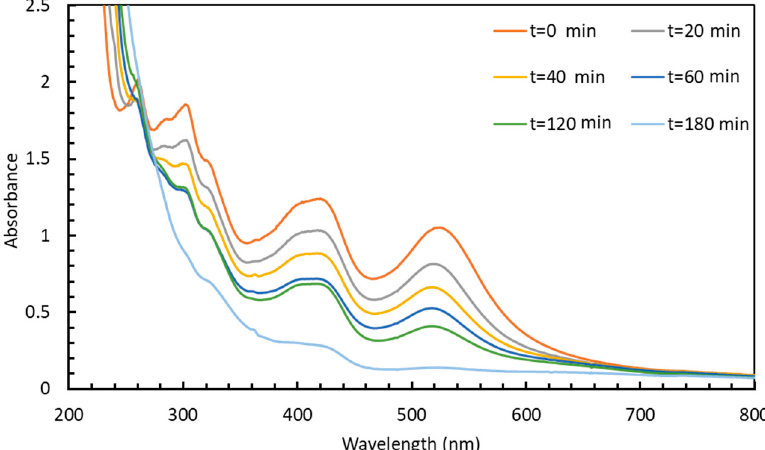
Figure 9. Temporal evolution of the UV-visible spectra of a deaerated aqueous solution containing 5 × 10 − 4 M potassium hexacyano ferrate in the presence of 15 nm Au-NPs@citrate under Xe lamp irradiation (equipped with an optical cutoff filter at 450 nm). Optical path length: 1 cm.